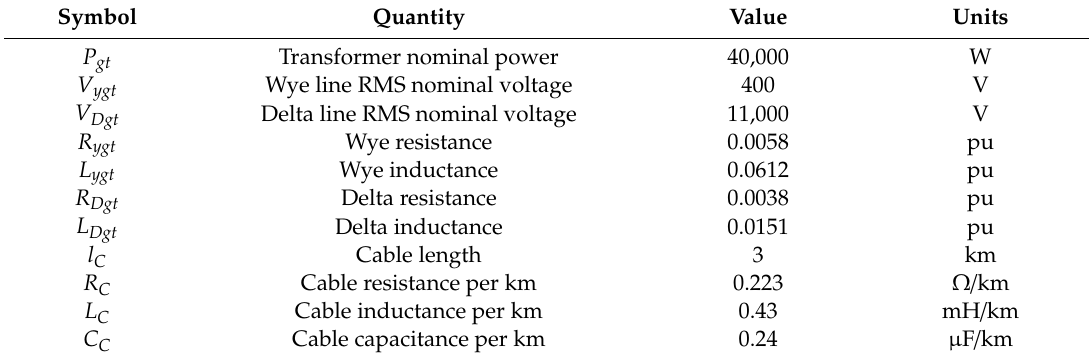
Table 4. Parameters of the power transmission